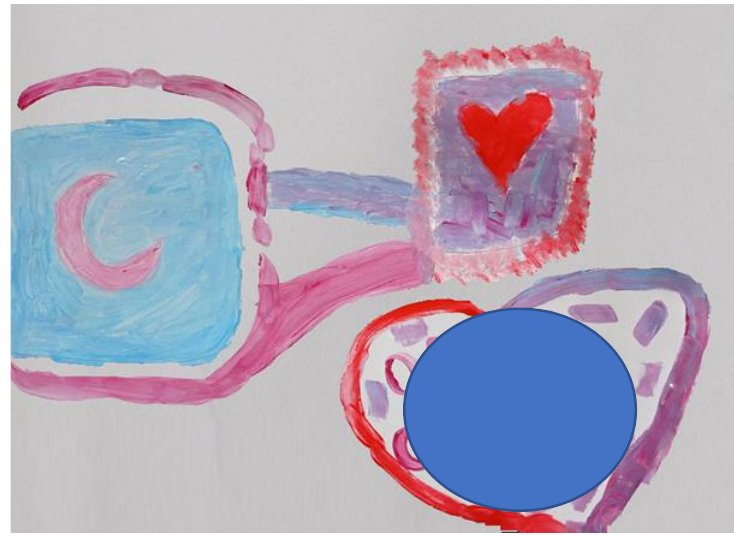
Figure 3. Lianne and her